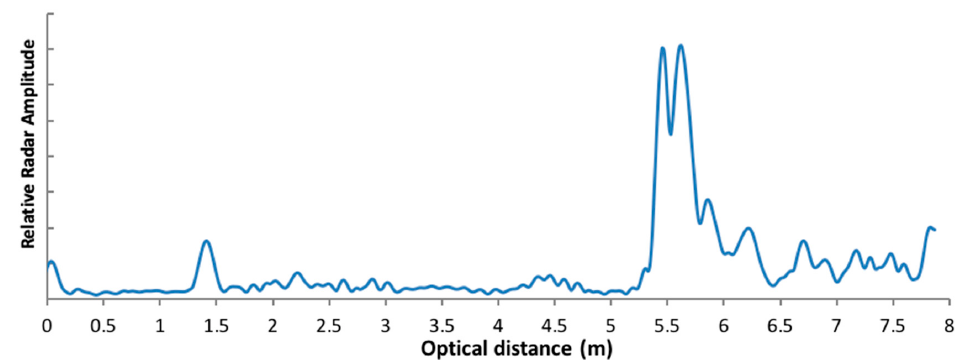
Figure 6. Relative radar signal amplitude (Y axis, starting from distance 0) measured from a bridge over ice at a height of 5.5 m. The width of the two peaks detected around 5.5 m correspond to 9 cm ice thickness.